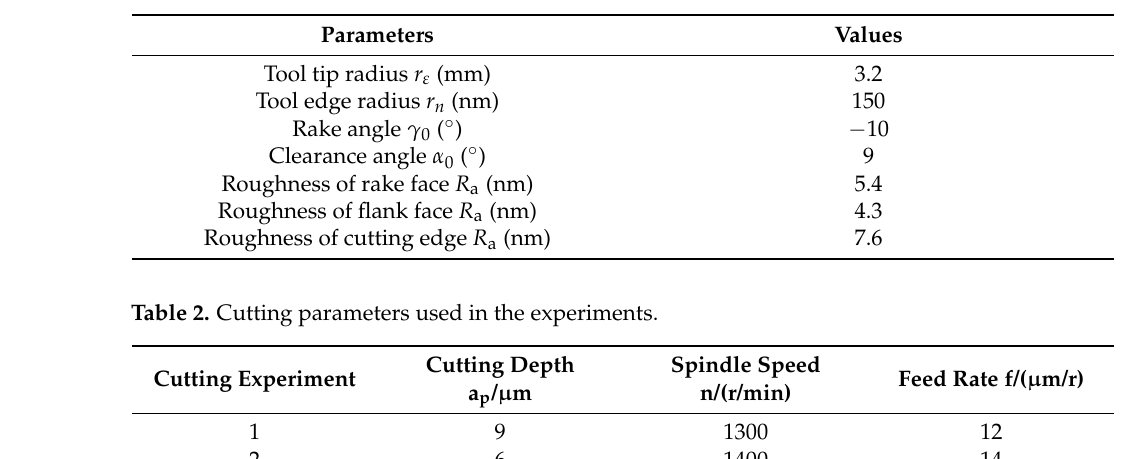
Figure 1. The KDP crystal machining experiment: ( a ) cutting experiment; ( b ) position of the (001) face in the KDP crystal. Table 1. The tool parameters used in the experiments.